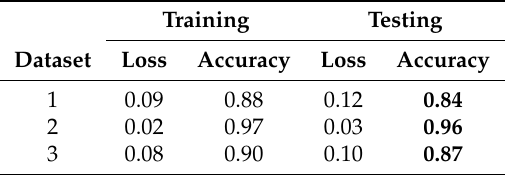
Table 12. Performance of Model [5] on Lex-Pos sequences.